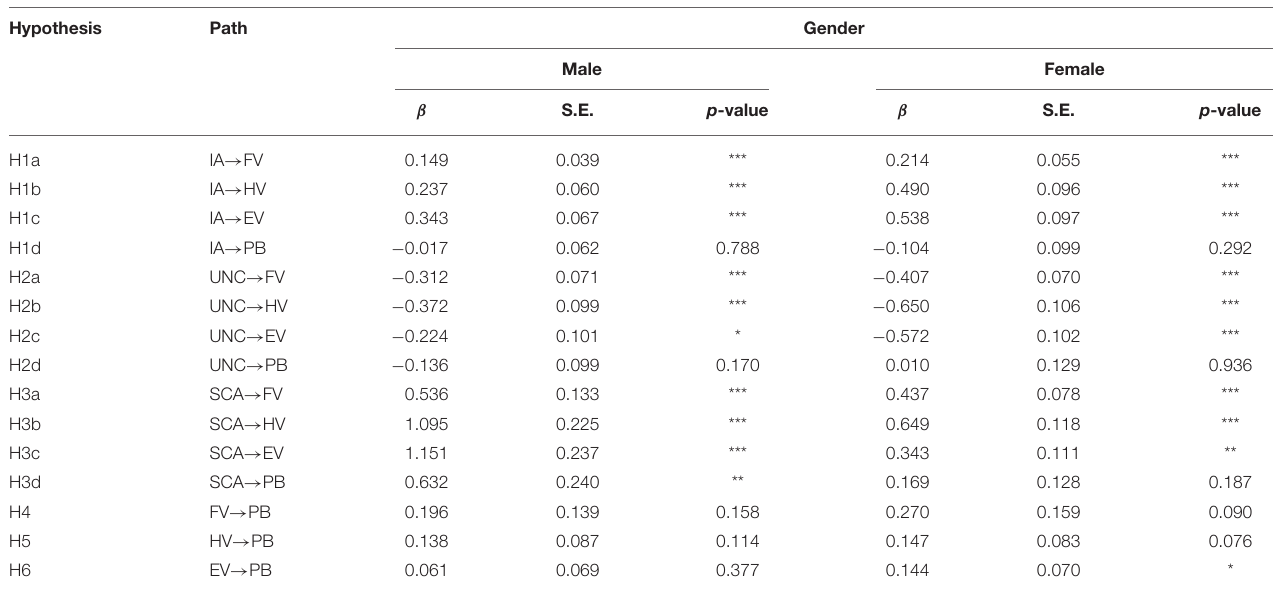
TABLE 8 | Coefficient of group